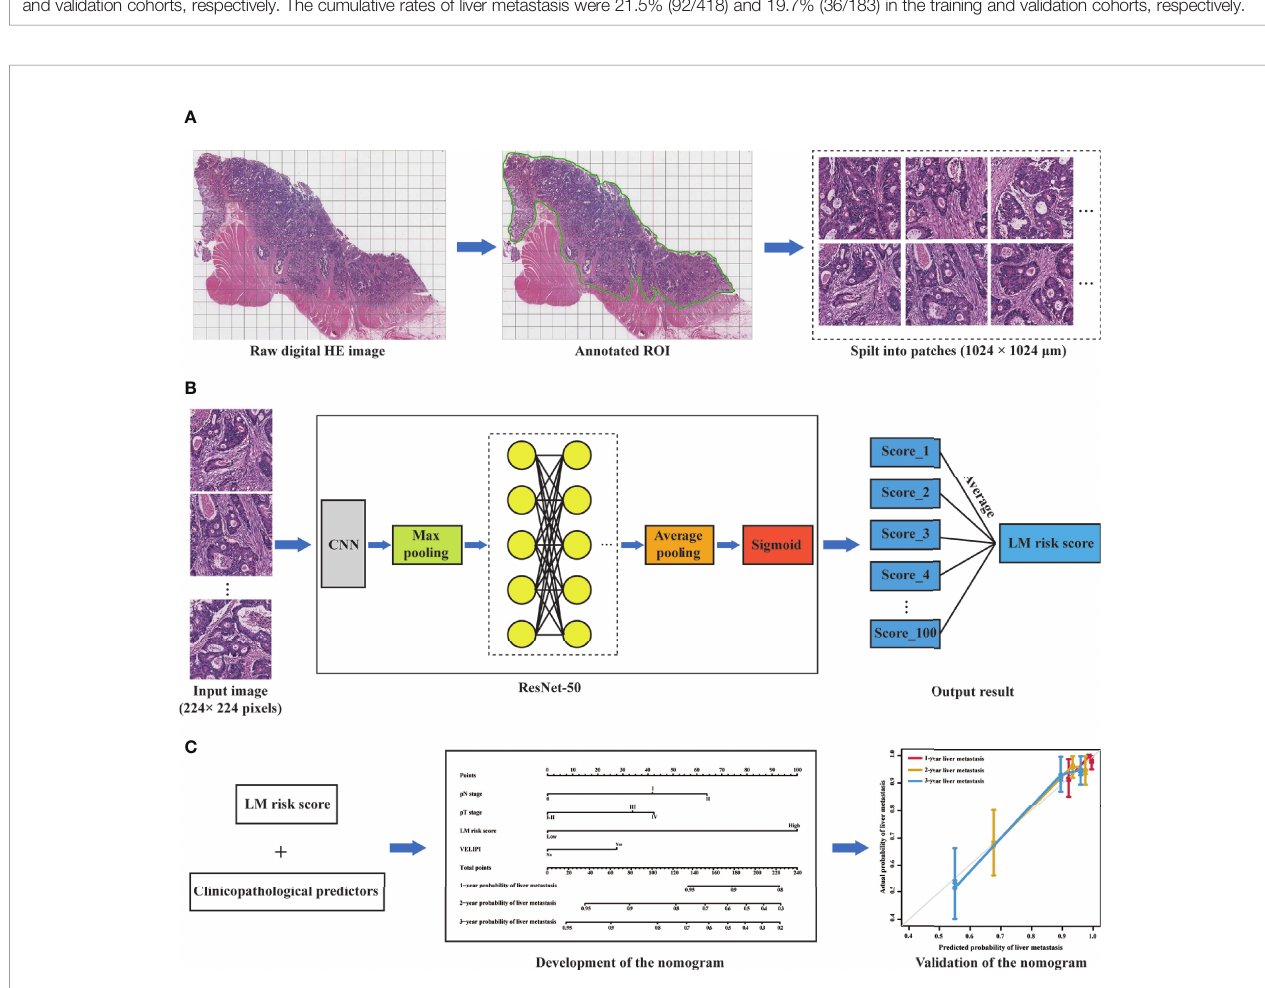
FIGURE 3 | Work fl ow of this study. (A) Selection of the ROI on the digital HE image. The tumor ROI was then segmented into patches of 1024 × 1024 m m. (B) A total of 100 patches were randomly selected from each patient, and the liver metastasis likelihood of each patch was predicted by a deep learning model based on ResNet-50. Then, the probability values of the 100 patches were merged to generate an average value as the LM risk score. (C) A nomogram was developed based on the LM risk score and clinicopathological predictors in the training cohort and veri fi ed in the validation cohort. ROI, region of interest; CNN, convolutional neural network; ResNet-50, 50-layer residual network; LM, liver